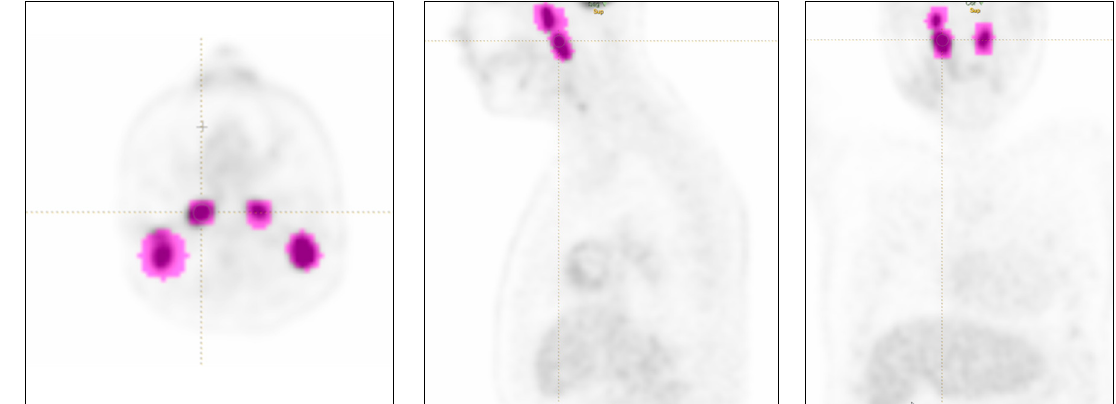
Figure 1. PET contouring using LifeX software of an 18-year-old male patient with Stage I Hodgkin Lymphoma.